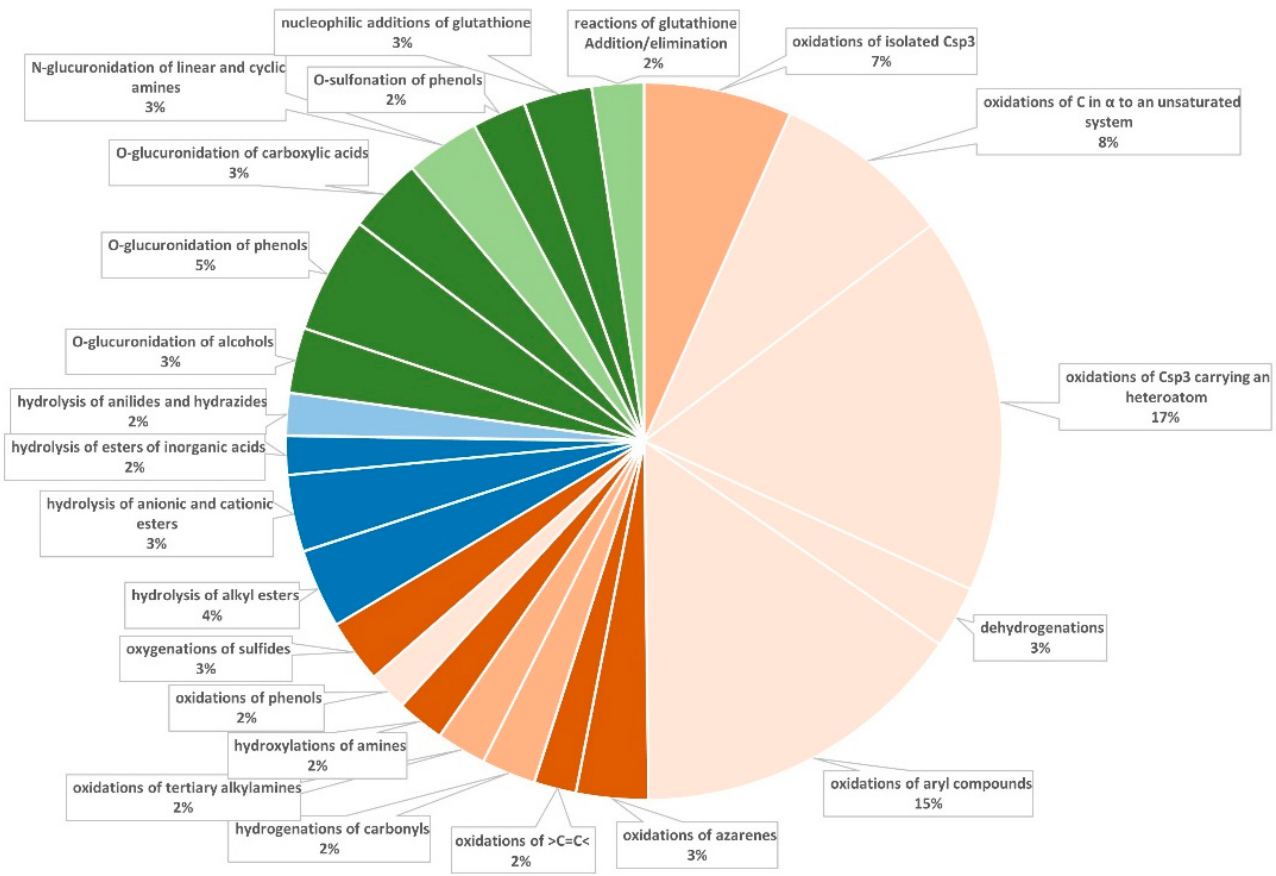
Figure 1. Pie charts representing the predictive performance and relative abundance of the classes ( top ) and subclasses ( bottom ) as subdivided into the three major classes by color coding, detailed in the legend in the